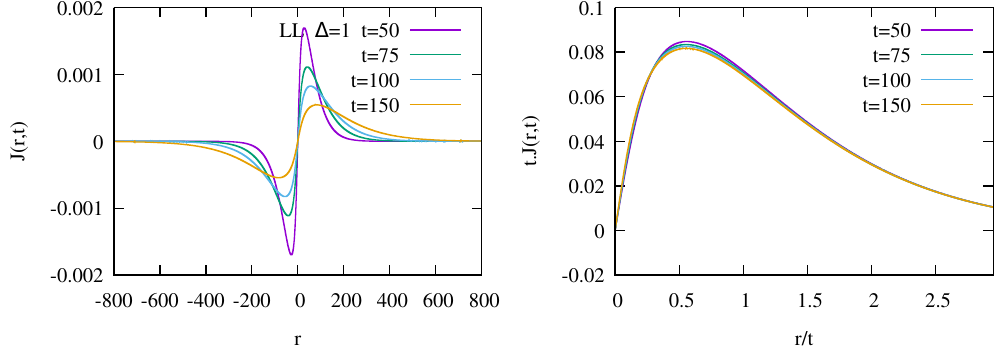
(cid:1) (cid:126) Ω · (cid:0) (cid:126) Ω × (cid:126) Ω at ∆ = 1, plotted as a r rr | . If we further assume r . As a r